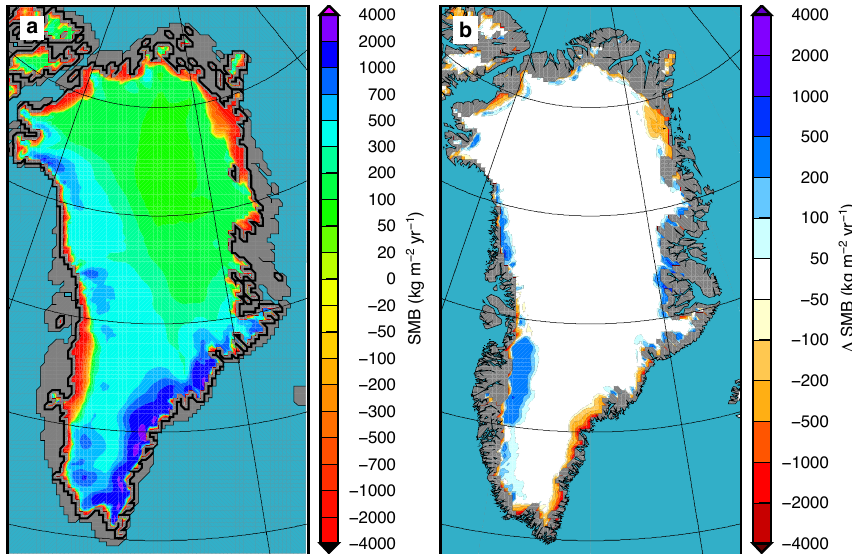
Fig. A1. (a) SMB using the PDD model and (b) difference with present-day SMB from Ettema et al. (2009) applied to the present-day observed ice